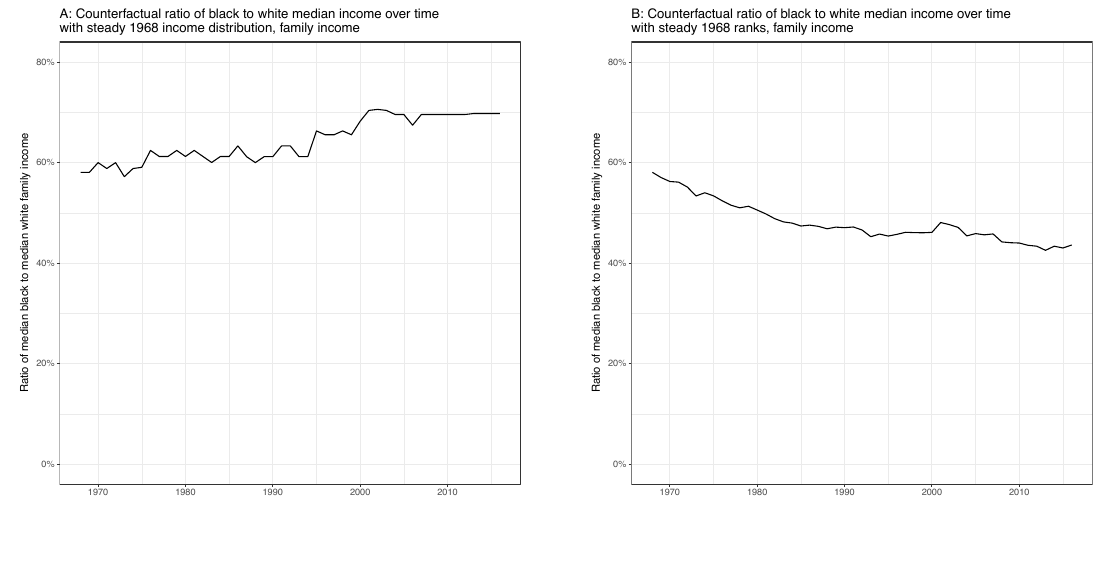
Figure 6: Counterfactual